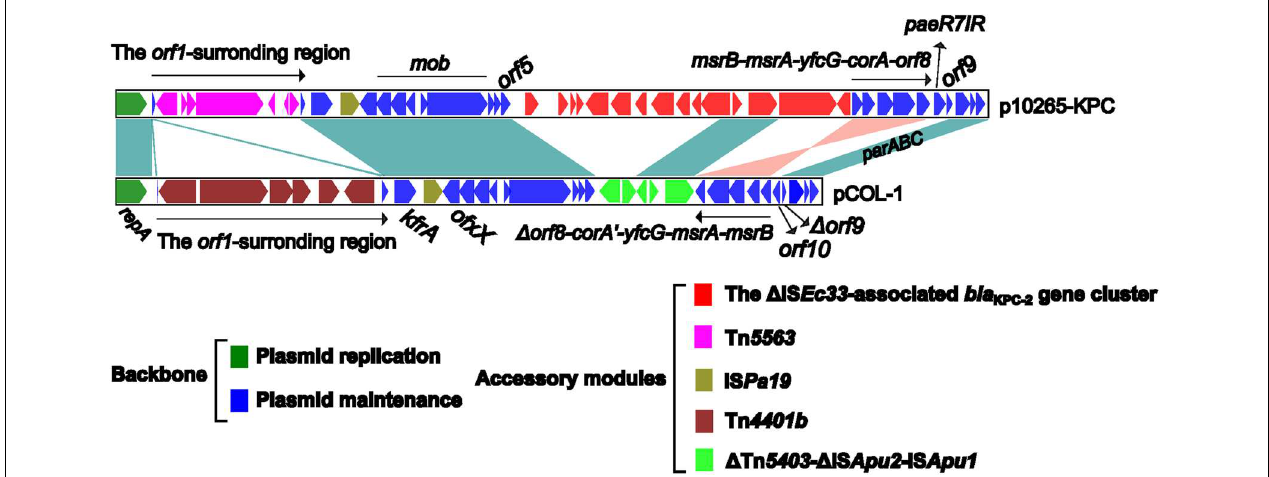
FIGURE 3 | Linear comparison of sequenced plasmids p10265-KPC and pCOL-1. Genes are denoted by arrows and colored based on gene function classification. Shading regions denote shared regions of homology ( > 95% nucleotide similarity).